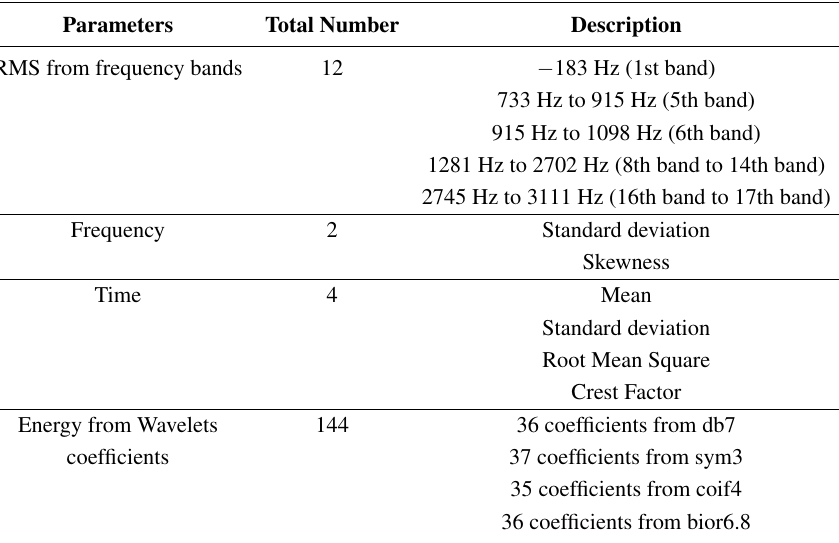
Table 4. Best individual by using multi-stage selection.